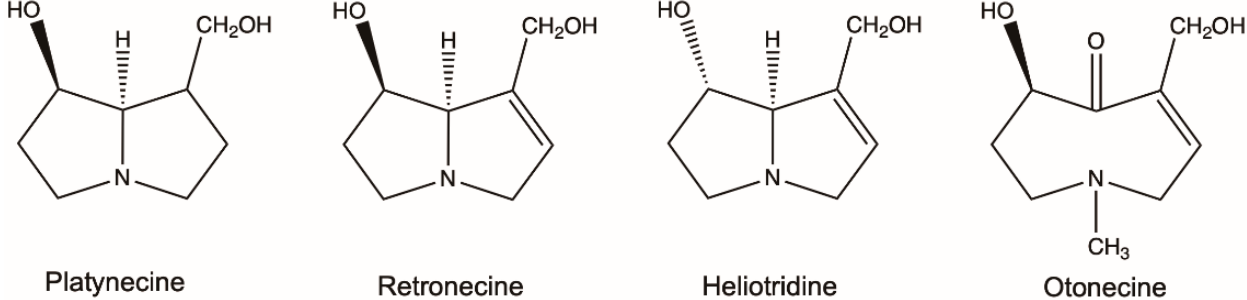
Figure 2. Most common necine bases in pyrrolizidine alkaloids (PAs). PAs are generally classified into four types based on the representative necine bases (platynecine, retronecine, heliotridine and otonecine).